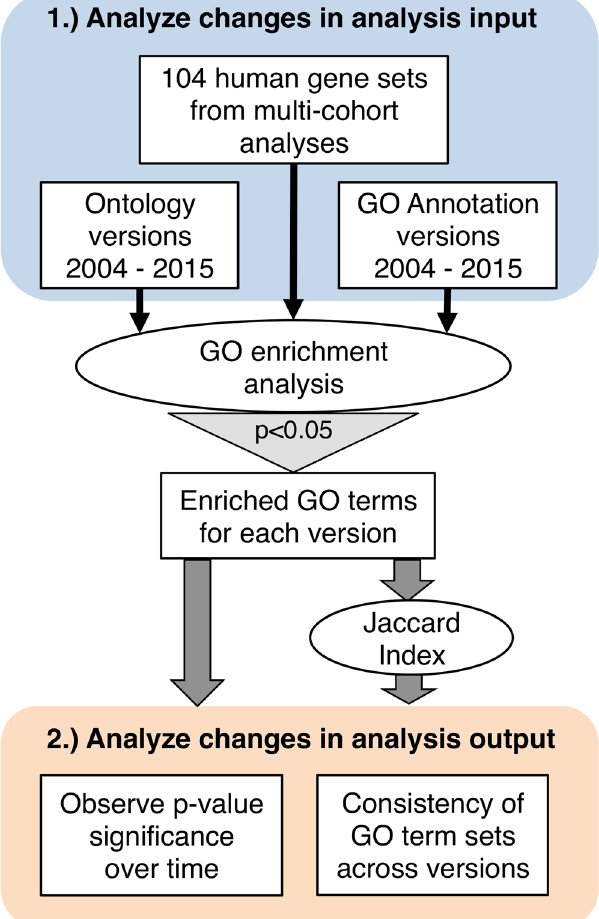
Figure 1. Overview of methods. We analyzed ( 1 ) changes in input variables of GO enrichment analyses and ( 2) how those changes affected enrichment analysis results over